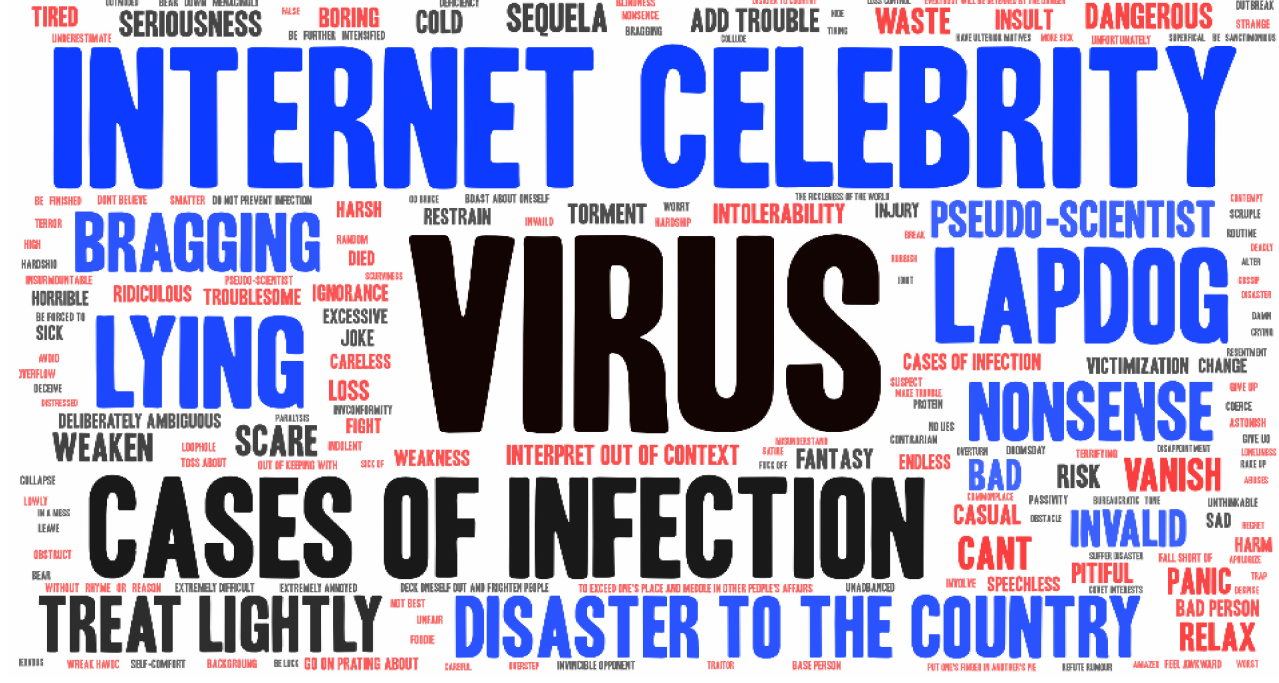
Figure 3. Keywords with negative